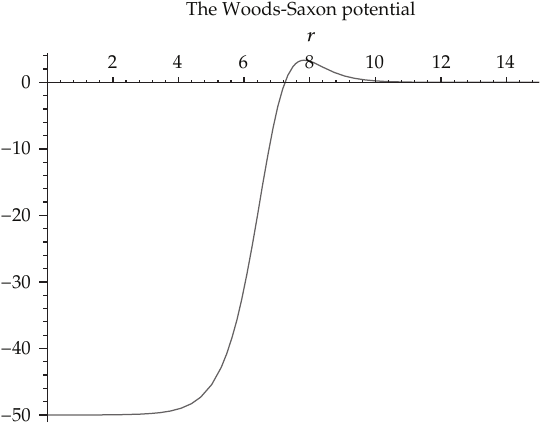
Figure 3: The Woods-Saxon